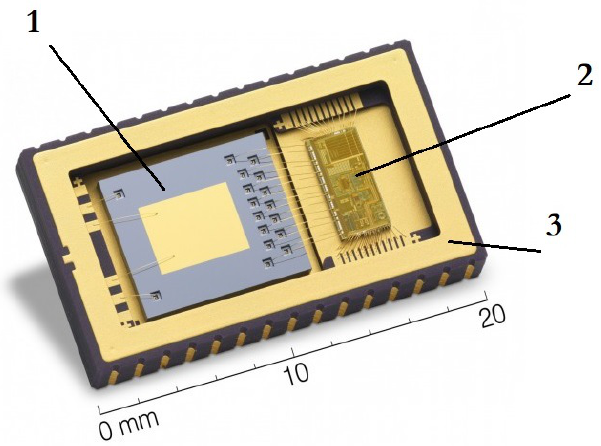
Figure 1. MEMS gyroscope (Tronics Gypro2300LD). ( 1 ) SE; ( 2 ) the ASIC; ( 3 )